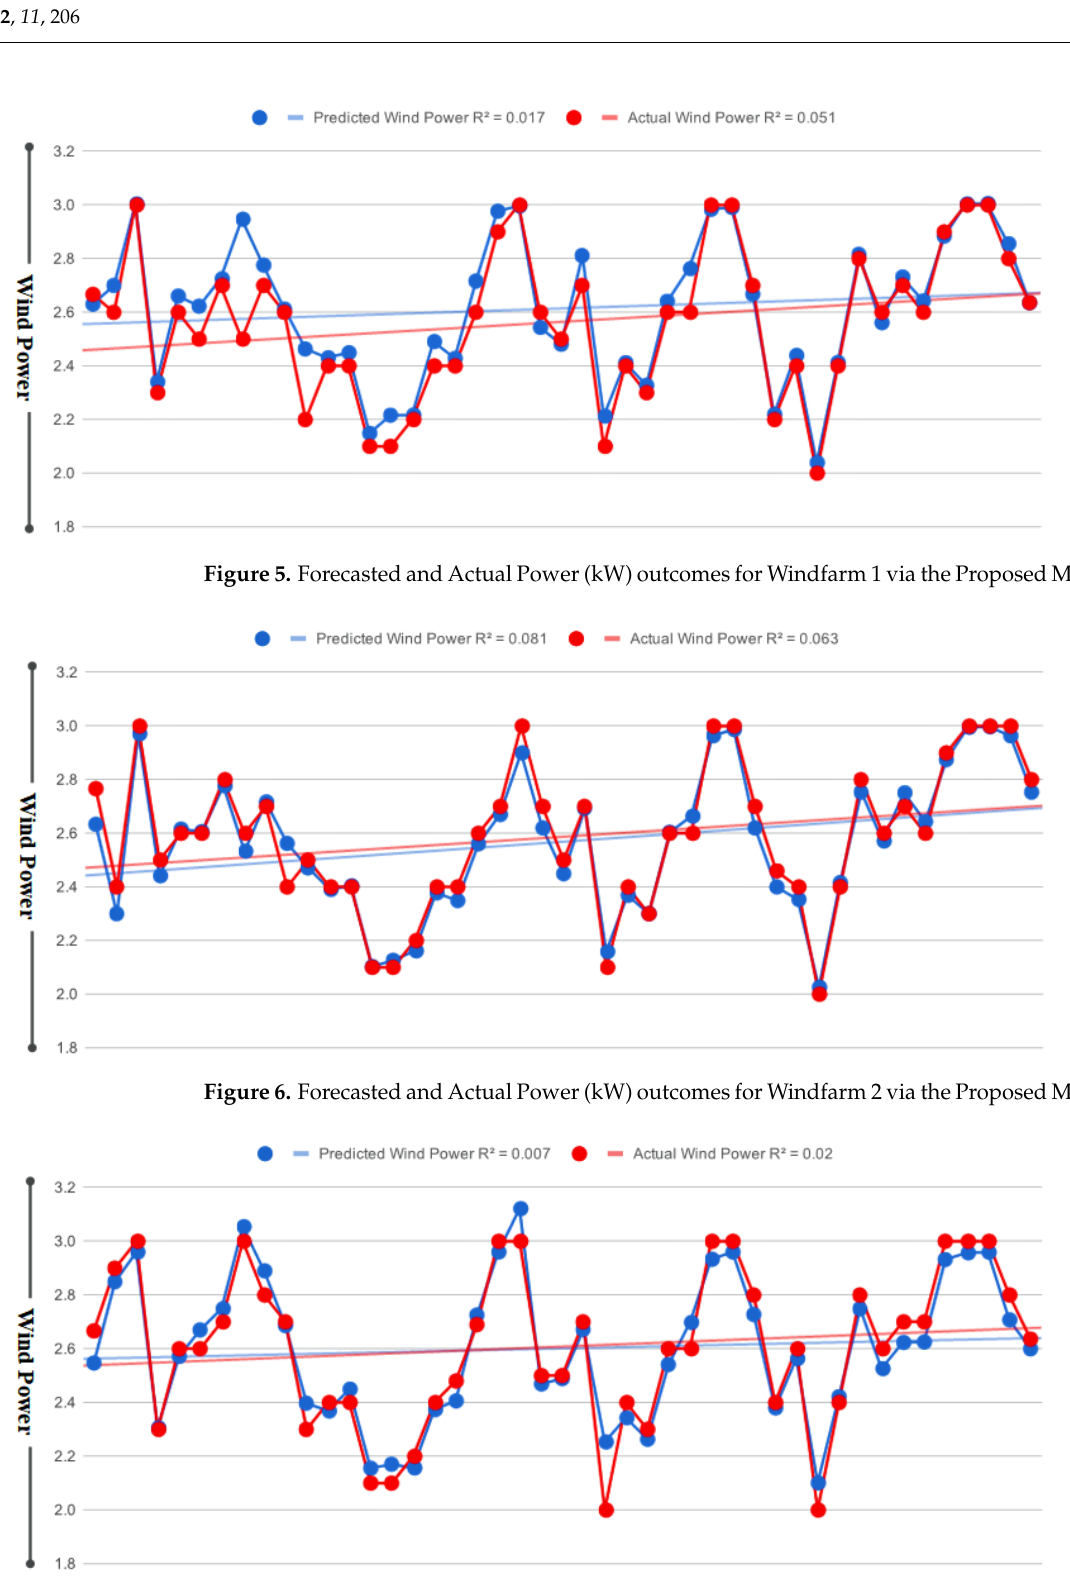
Figure 7. Forecasted and Actual Power (kW) outcomes for Windfarm 3 via the Proposed Methodology.